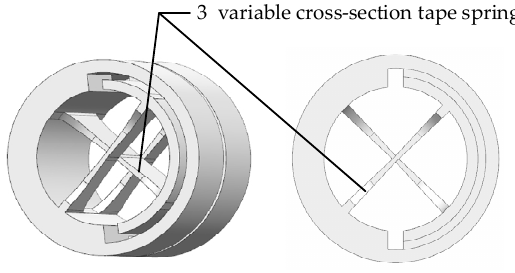
Figure 12. Cross axis flexural hinge with 3 variable cross-section tape springs.